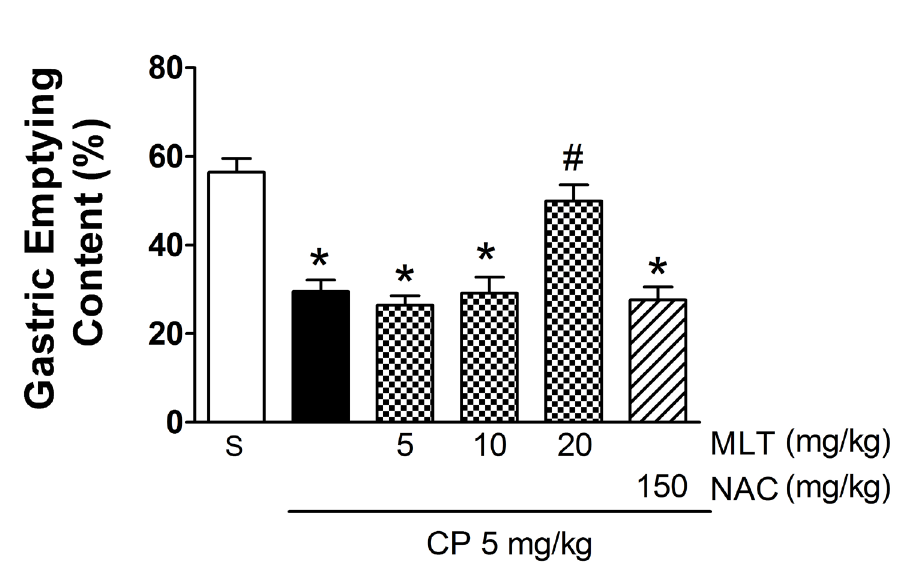
FIGURE 1 - Effects of pretreatment with melatonin (MLT) or N-acetylcysteine (NAC) on the percentage of gastric dye emptied, as induced by cisplatin (CP) in mice. P < 0.05, *compared with the control group (S), # compared with the group treated only with cisplatin (ANOVA followed by Tukey